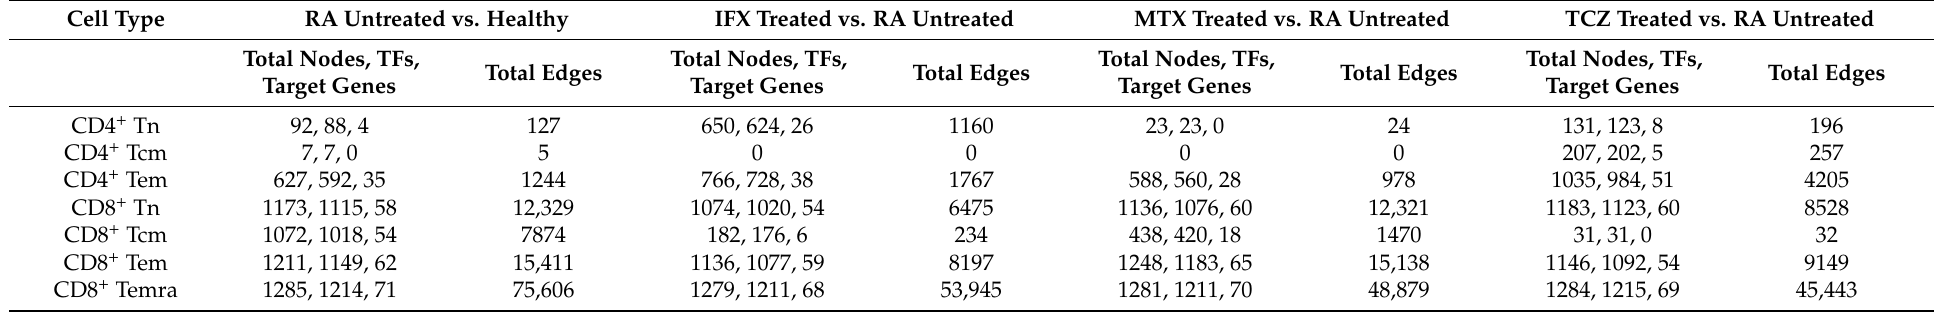
Table 14. Number of nodes and edges in the GTRD-annotated transcription factor–target gene network of untreated RA and treated RA T cell subsets. Cell